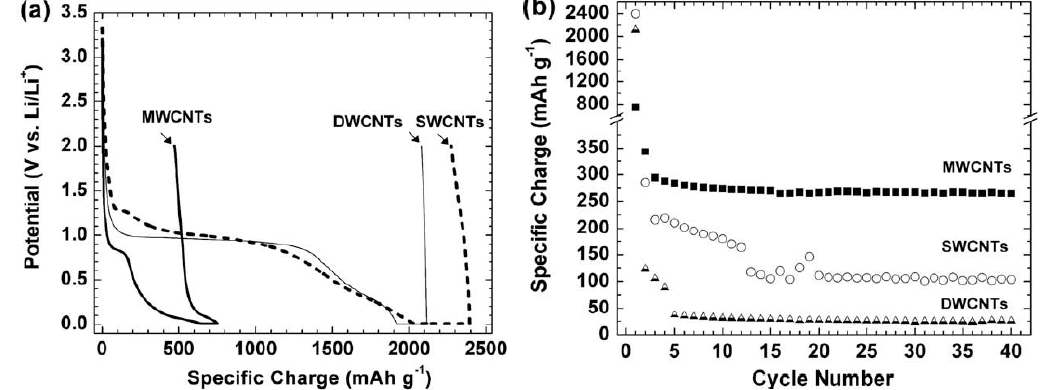
Figure 9. The electrochemical performance of the freestanding CNT films: ( a ) galvanostatic charge–discharge profiles in the 1st cycle; and ( b ) cycling behavior between 0.01 and 2.00 V vs. Li/Li + at a specific current of 25 mAg − 1 . (Reprinted with permission from [40]. Copyright (2009) by